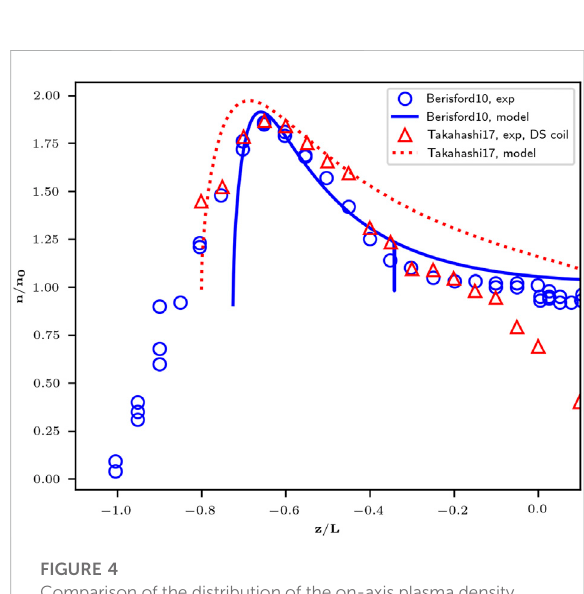
FIGURE 4 Comparison of the distribution of the on-axis plasma